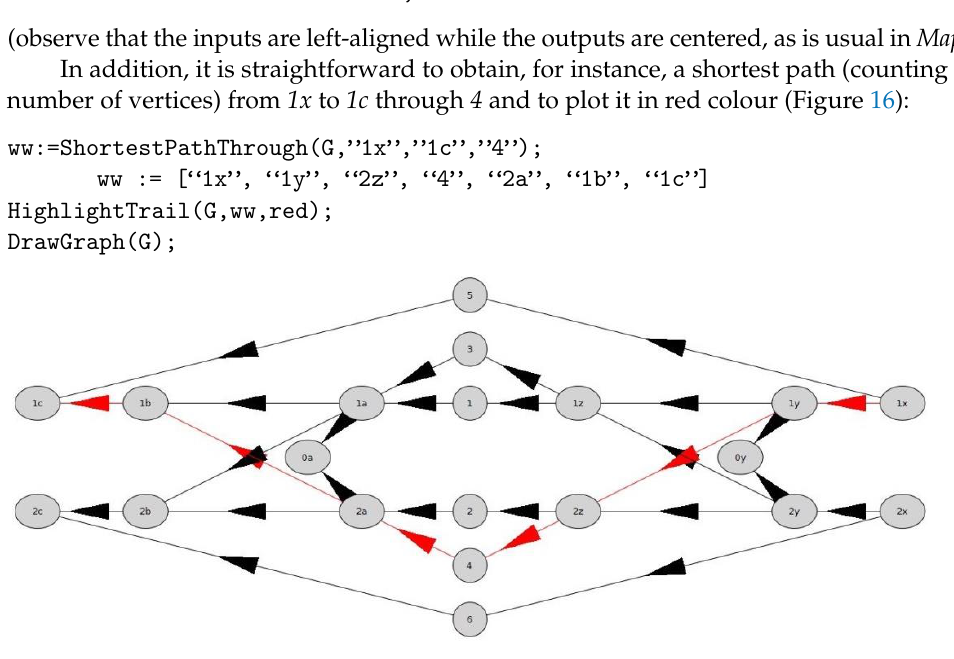
Figure 16. A shortest path from 1x to 1c through 4 .